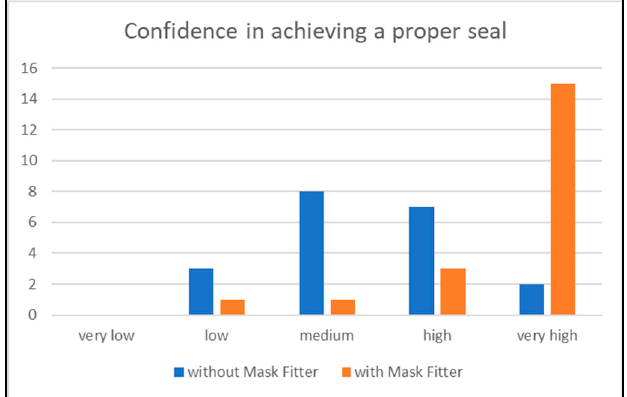
Figure 9. Confidence in achieving an appropriate seal with and without Mask Fitter.